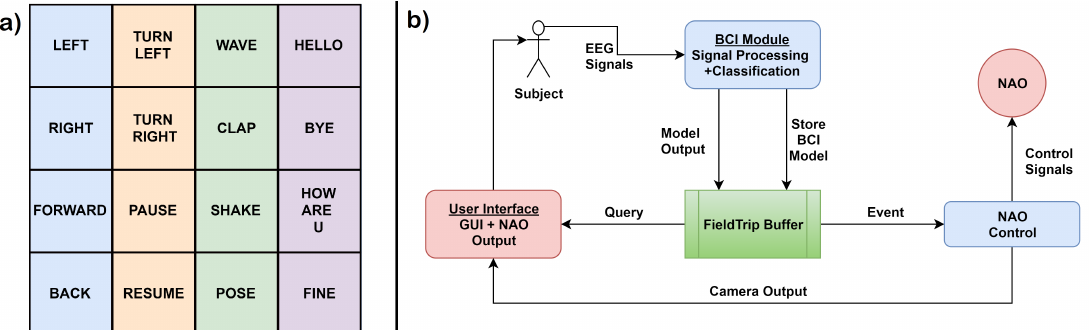
Figure 8. ( a ) 4 × 4 Grid showing high-level commands and ( b ) abstract system pipeline for telepresence (adapted from: